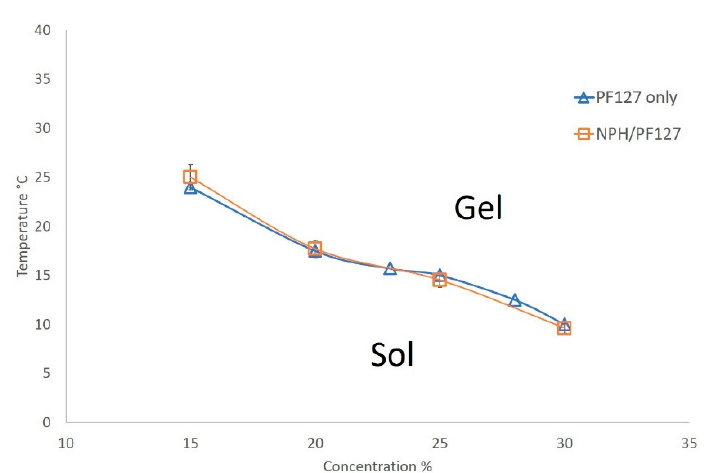
Figure 2. Phase diagram of the lower sol-gel transition of PF127 in phosphate-bu ff ered saline (PBS) (pH 7.4) with or without NPH. Data are expressed as means ± S.D. ( n = 3).